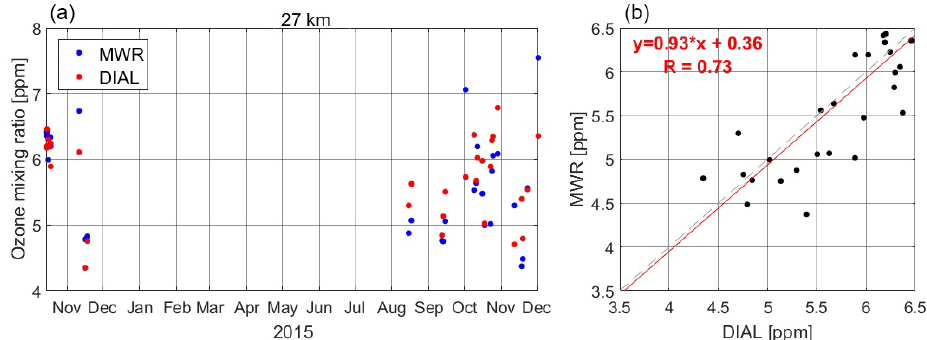
Figure 6. (a) DIAL (red dots) and MWR (blue dots) ozone mixing ratio at the same time for 27km between October 2014 and Decem- ber 2015; (b) scatterplot between DIAL and MWR measurement.